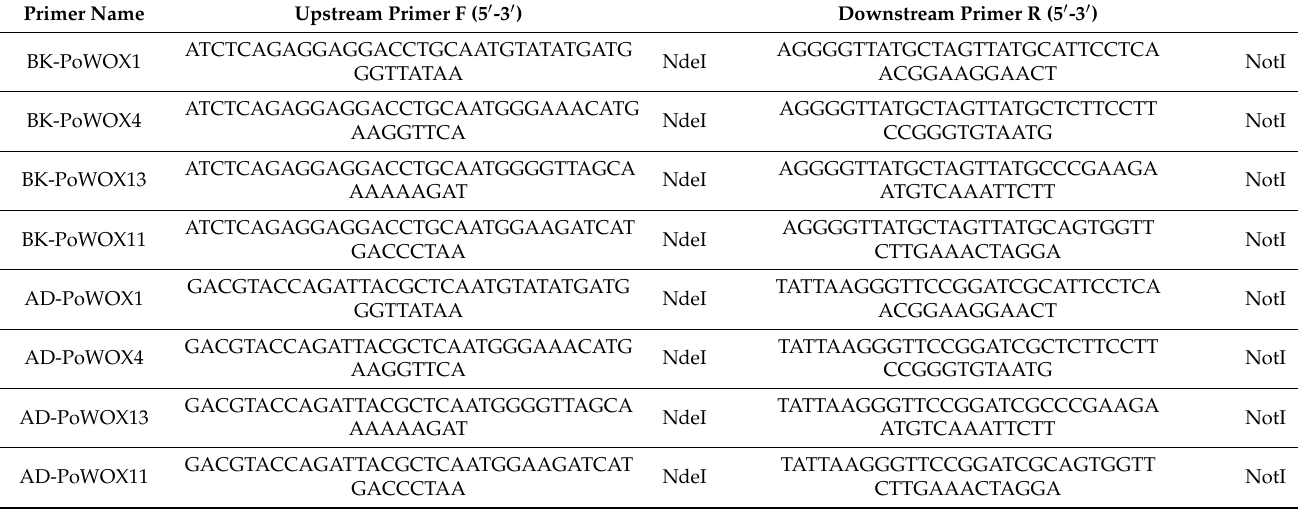
Table 4. Primer sequences for the construction of pGADT7 and pGBKT7 recombinant vectors on PoWOX genes in